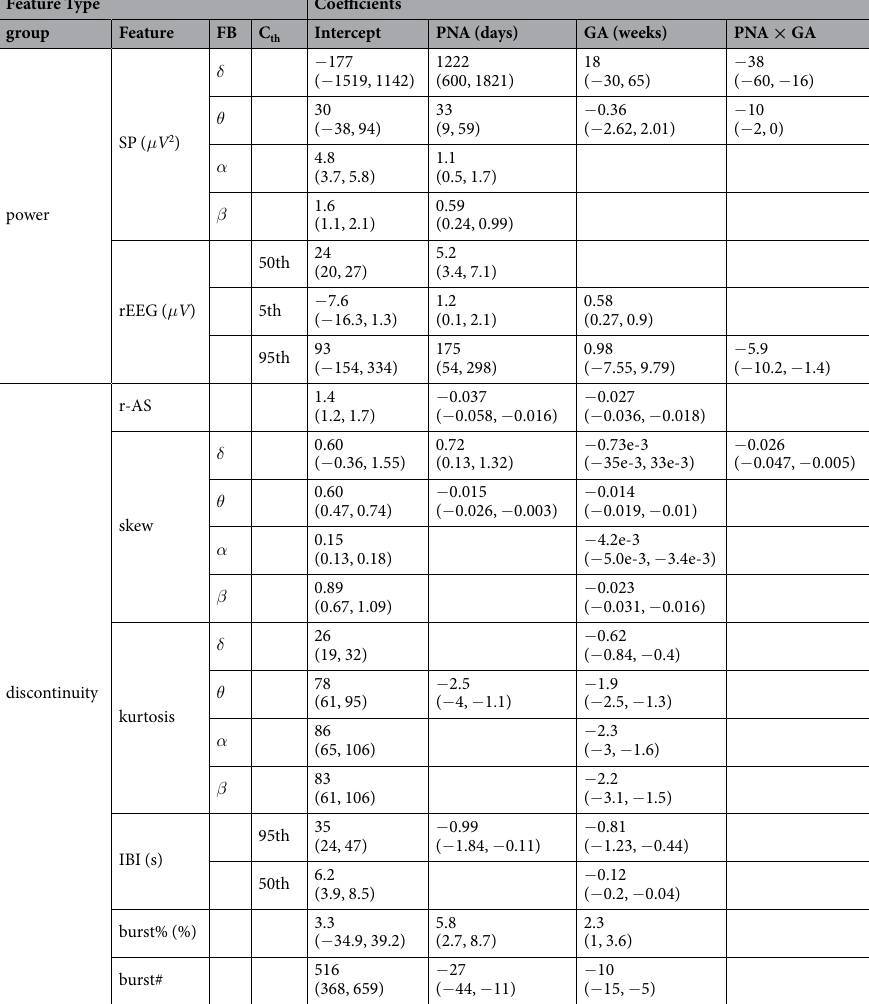
36, 48, and 60 h time points. After EEG epoch selection, the median number of epochs per infant was 3.5 (IQR: 3 to 5; range: 1 to 6). Fitting mixed-effects models.